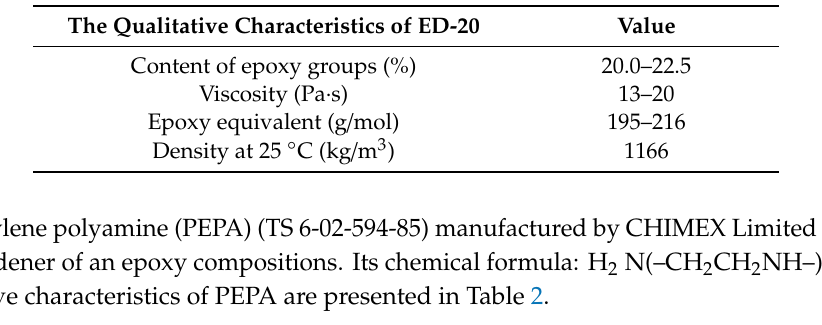
Table 2. Properties of PEPA.